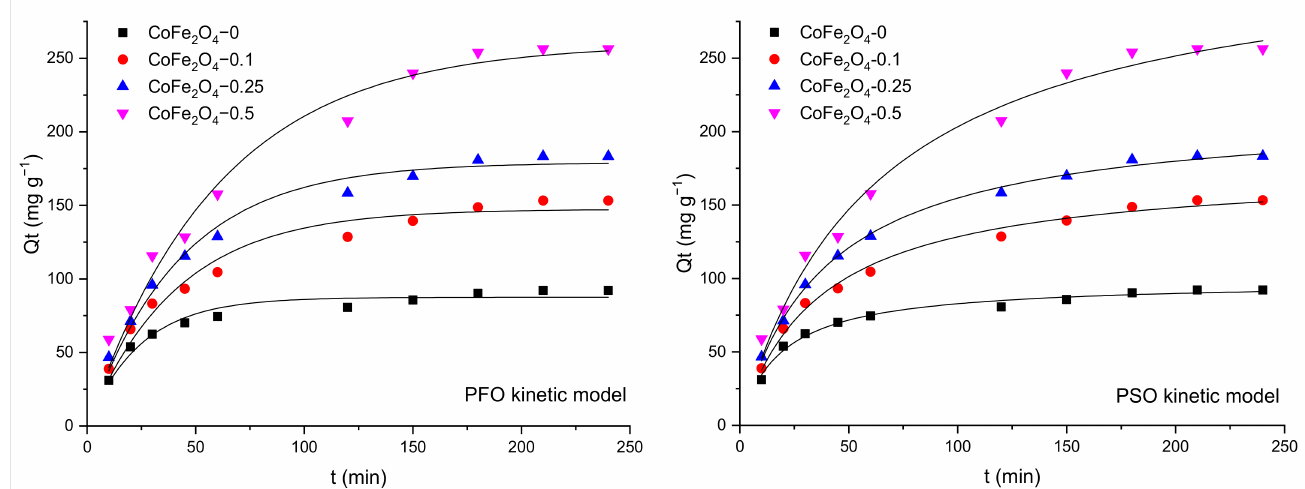
Figure 14. Graphical representation of the PFO and PSO kinetic models for removal of MO by adsorption onto CoFe 2 O 4 samples from single solutions (nonlinear